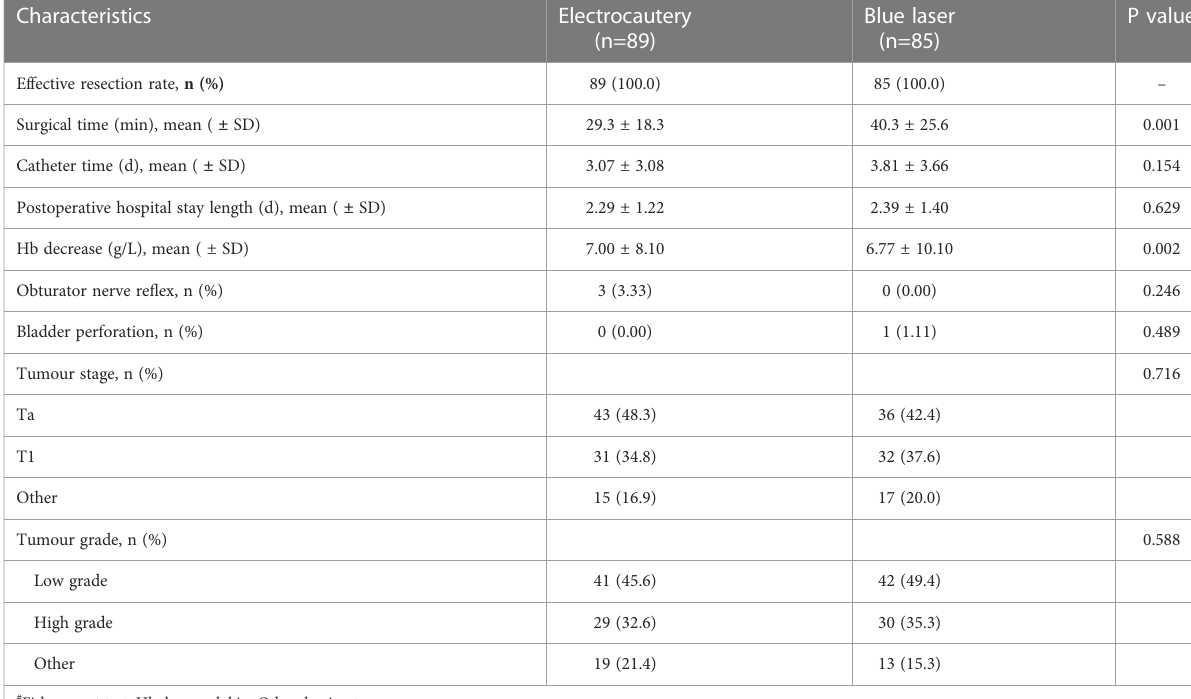
TABLE 2 Perioperative and postoperative pathological characteristics of patients.